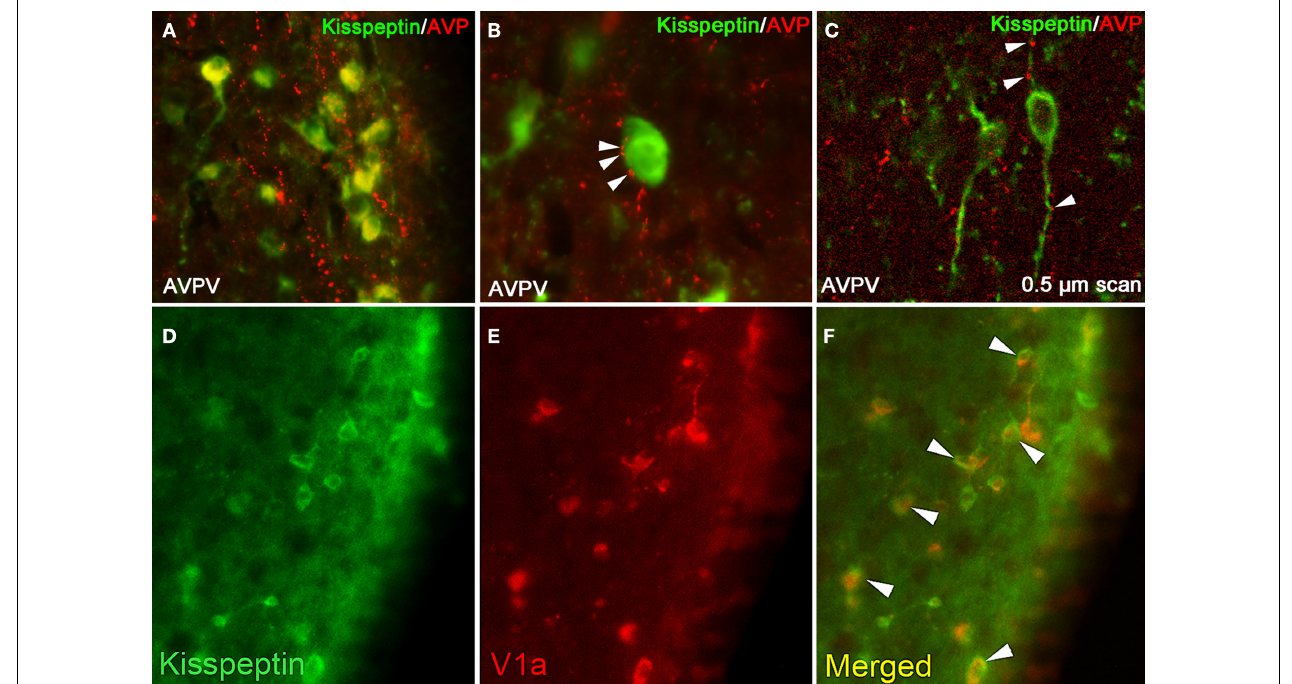
confirming AVP-ir contacts upon kisspeptin-ir cell body and processes. In (B,C) , Arrows are indicative of close contacts. (D–F) Kisspeptin cells in the AVPV express theV1a receptor. (D) Low-power photomicrographs of kisspeptin-ir cells in the AVPV, (E) V1a-ir cells in the AVPV, and (F) the merged image showing overlap between kisspeptin-ir andV1a-ir. Modified fromWilliams et al.